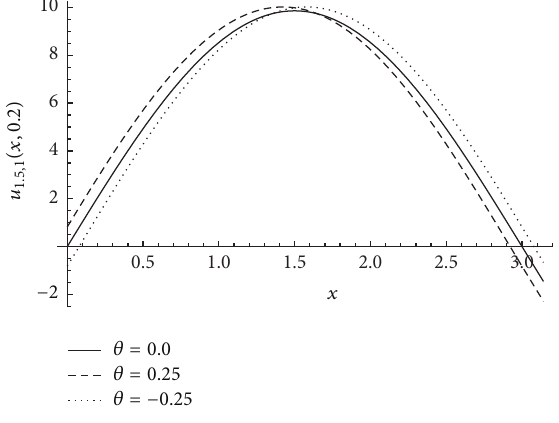
Figure 1: The behavior of the four terms of OHAM solution of (49) at 𝑡 = 0.2 , 0 < 𝑥 < 𝜋 , and the fractional parameters 𝛼 = 1.5 and 𝛽 = 1 and the skewness 𝜃 = 0, 0.25, −0.25 .